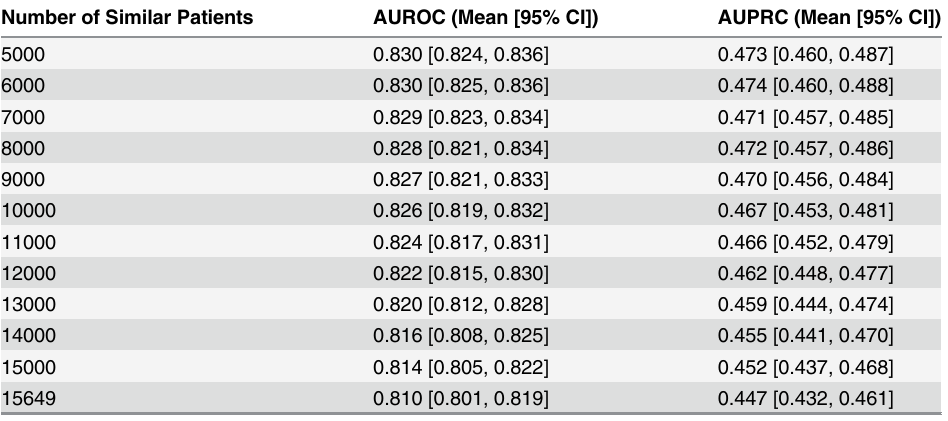
Table 3. Mortality prediction performance of logistic regression as a function of the number of similar patients used in training. Number of Similar